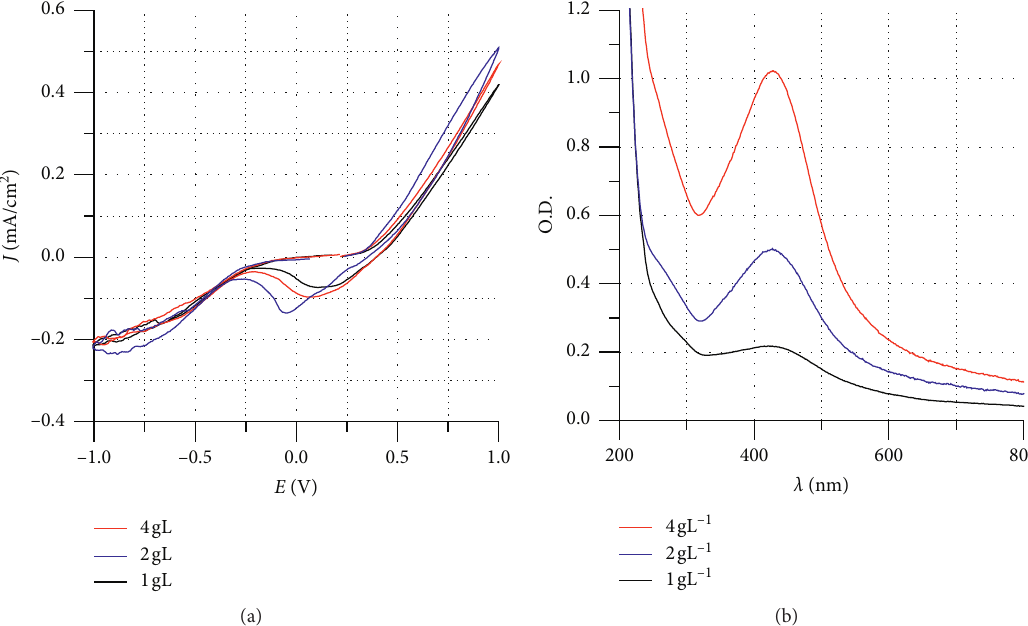
Figure 4: Cyclic voltamperograms (a) and spectral dependences of optical absorption (b) of AgNPs, synthesized ultrasonically in an aqueous solution of RL (1, ... , 4g/L) at the temperature of t � 20 ° C and the process duration of 20 cycles.